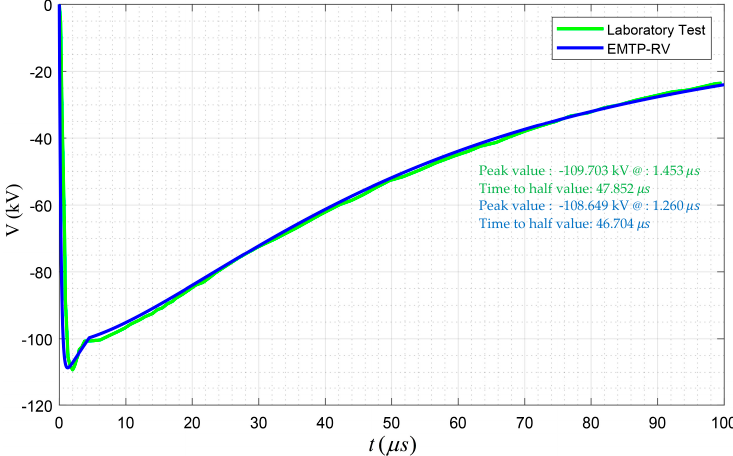
Figure 11. Applied impulse 110 kV in the presence of the spark gap, laboratory test and EMTP-RV model.